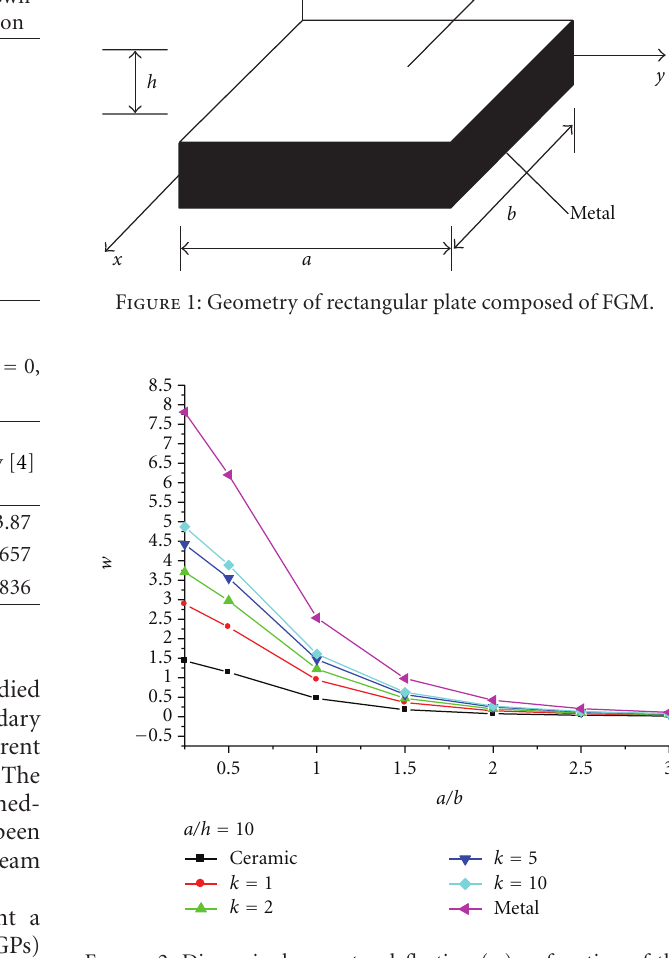
Figure 2: Dimensionless center deflection ( w ) as function of the aspect ratio ( a/b ) of an FGM